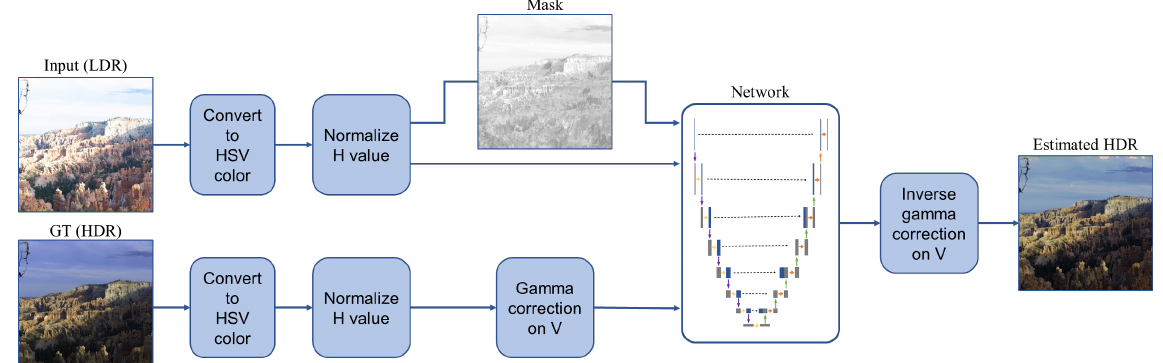
Figure 1. Our framework first converts the color space to HSV and normalizes H values. Then it creates a mask for each input LDR image and applies a gamma correction on V of the ground truth. It finally estimates an HDR image by applying an inverse gamma correction to the result from the